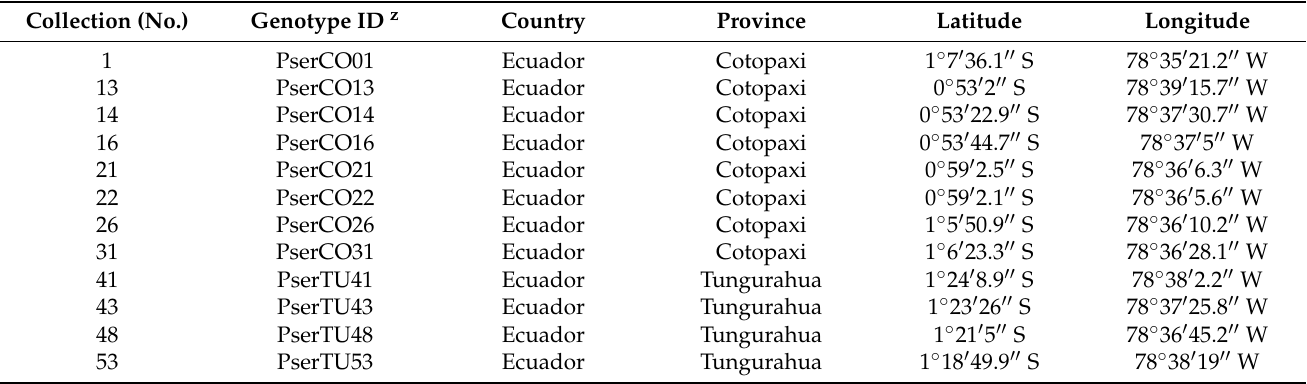
Figure 1. Map representing collection sites of Prunus serotina subsp. capuli genotypes, collected from 3 different provinces of Ecuador in 2016 and 2019. Table 1. List of Prunus serotina subsp. capuli genotypes, collected for fruit evaluation in the Andes region of